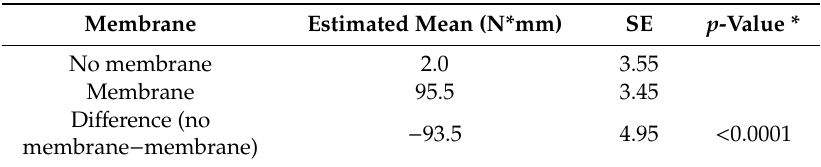
Table A4. Estimated mean energy to break for membrane (yes / no).